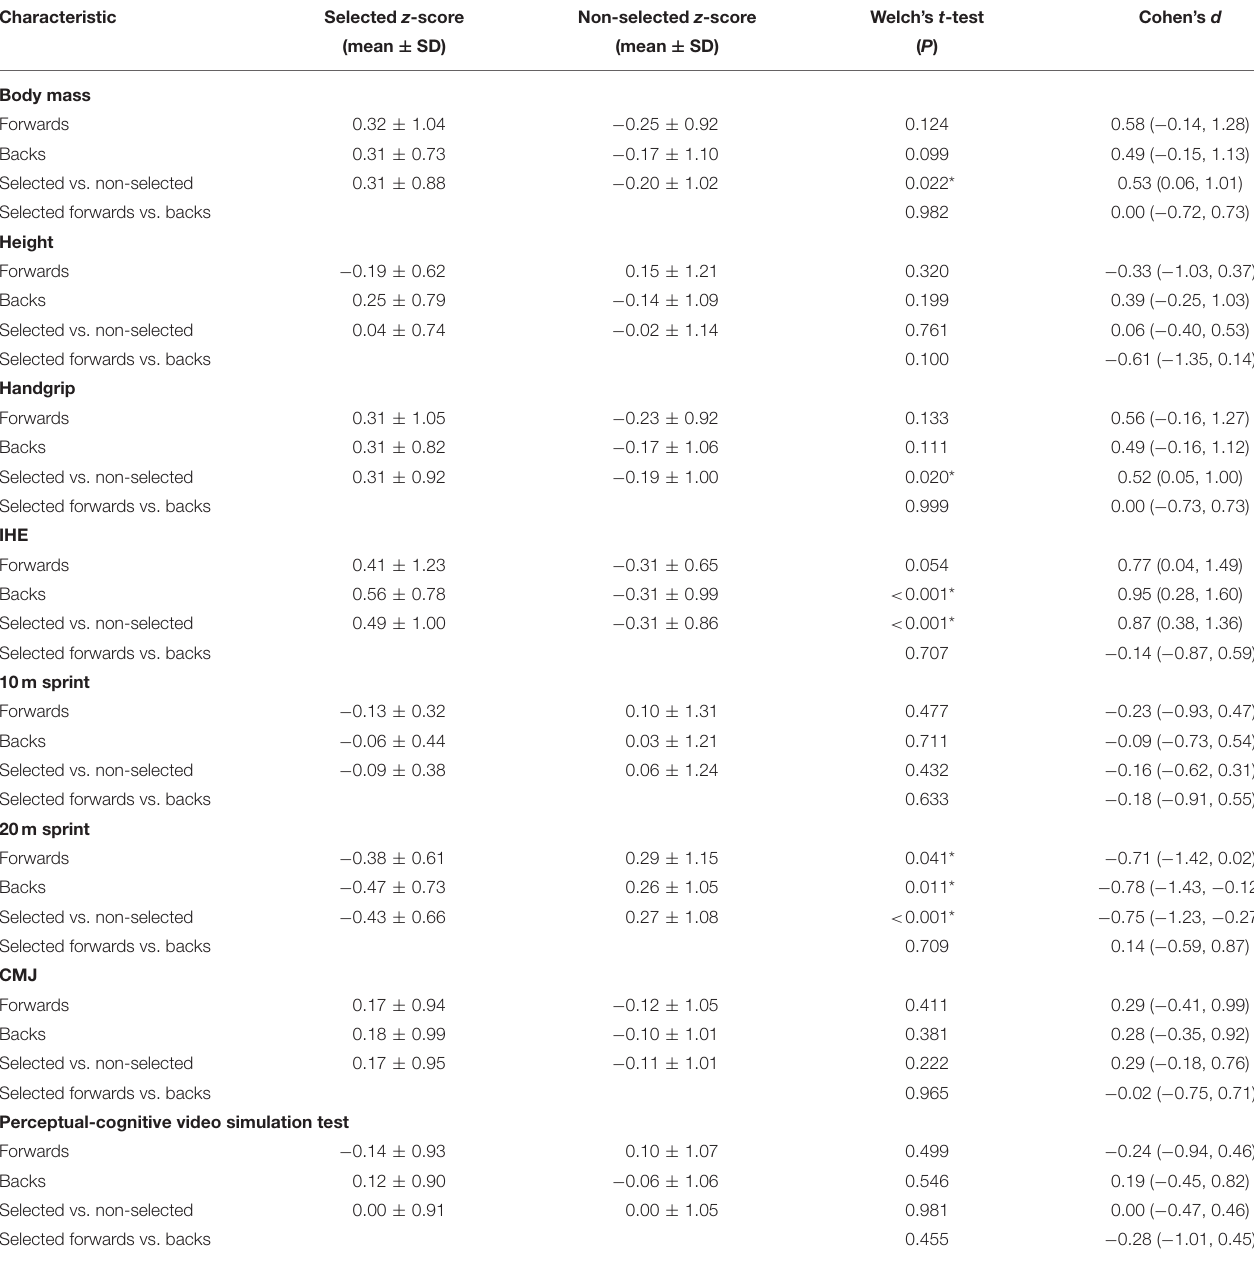
TABLE 3 | Z -scores and Welch’s t -tests for selected and non-selected players. Characteristic Selected z -score Non-selected z -score Welch’s t